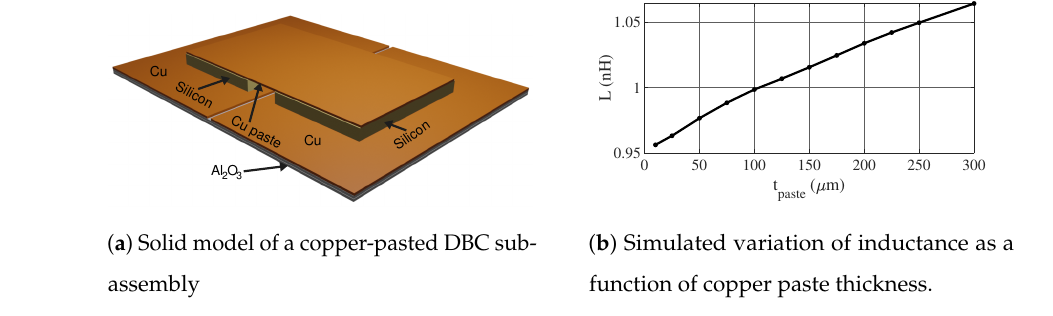
Figure 5. FE analysis of the Sinterconnects ( a ) the model and ( b ) the dependence of inductance on the Cu